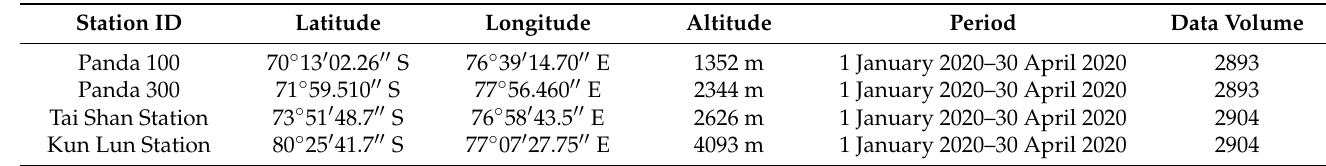
Table 1. Details of selected stations.